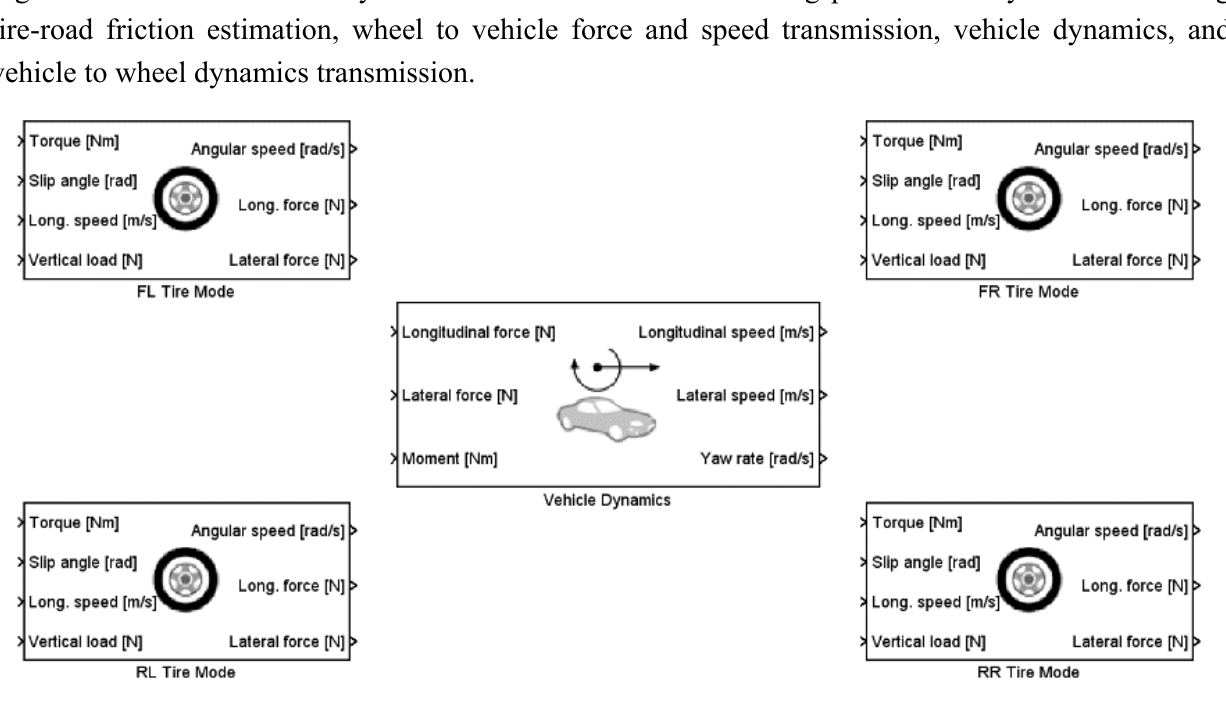
Figure 7. In-house EV dynamic